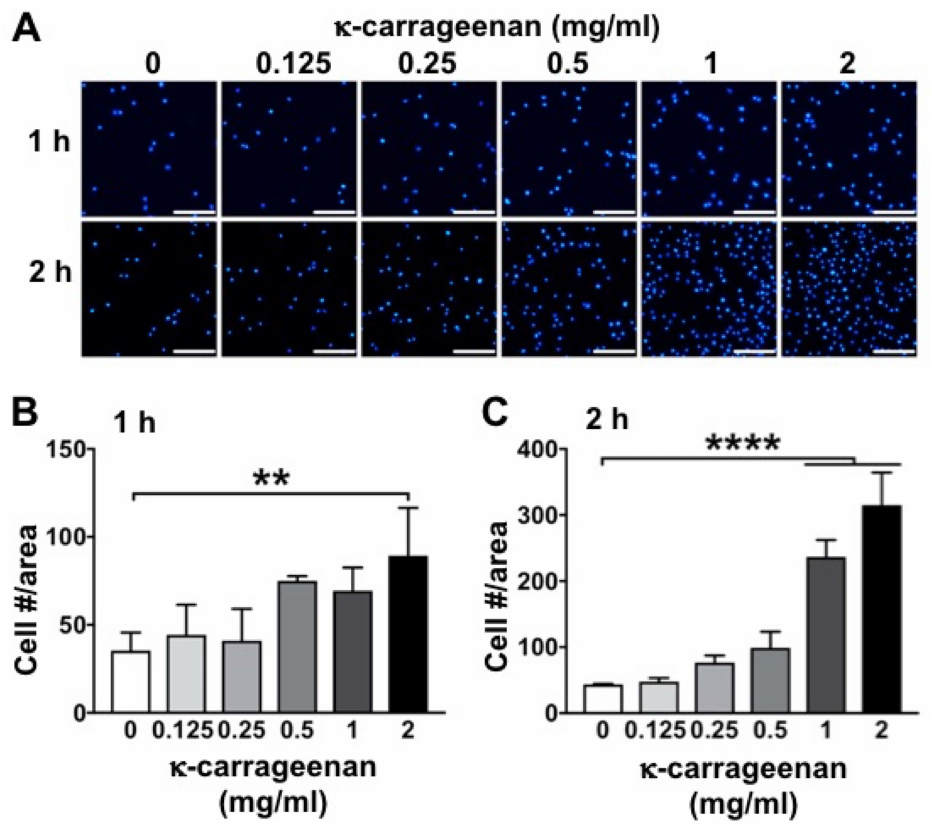
Figure 1. K-carrageenan-enhanced MC3T3-E1 pre-osteoblast adhesion at 1 and 2 h. ( A ) DAPI-stained nuclei of adhered cells. ( B ) Quantification of the number of adhered cells at 1 h. ( C ) Quantification of the number of adhered cells at 2 h. Values are mean ± SD from 3 independent experiments. Significant effect of κ -carrageenan, ** p < 0.01, **** p < 0.0001. Bar: 200 µ